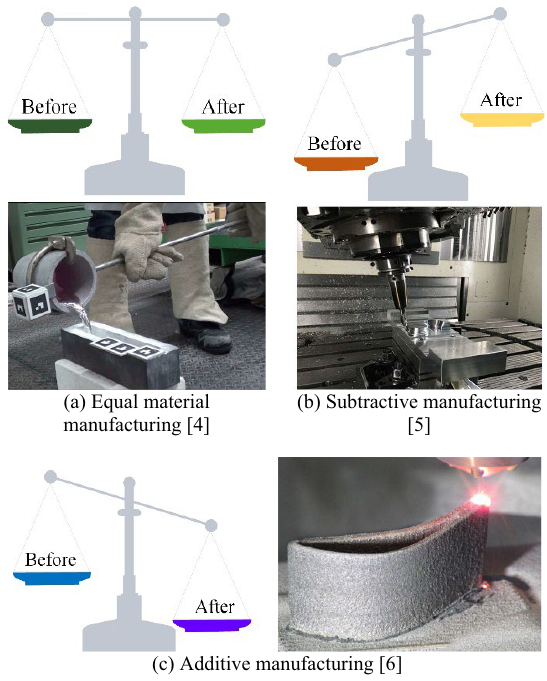
Figure 1 Industrial manufacturing classification: a Equal material manufacturing [4]; b Subtractive manufacturing [5]; c Additive manufacturing